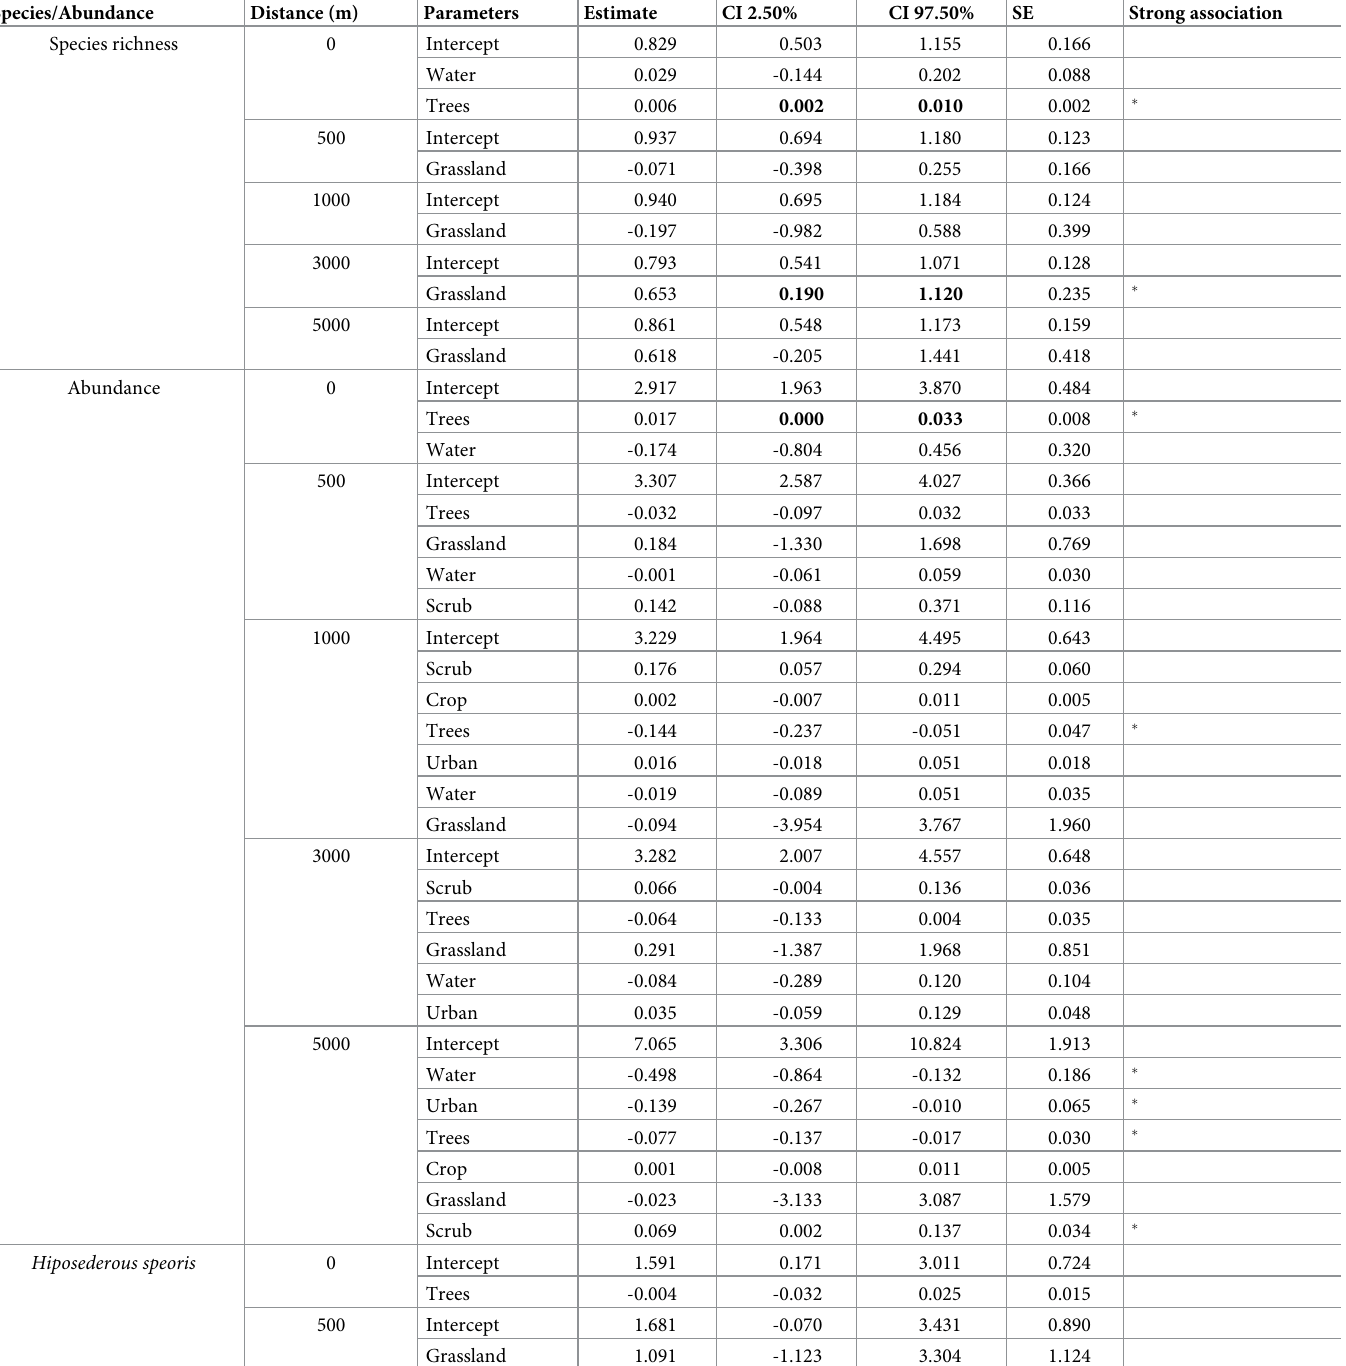
Table 3. Species response to land-use elements. Model averaged parameter estimates of top models ( < 2 Δ AICc) with non-overlapping confidence intervals are shown in the last column � The top models’ details are included as (S2 Table).